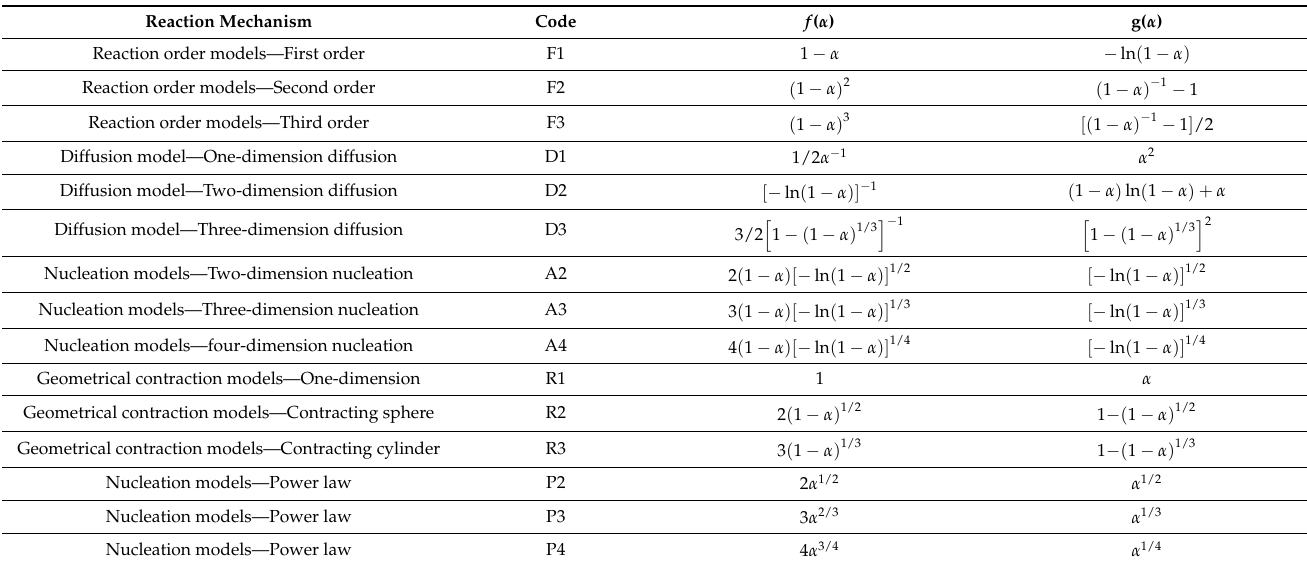
Table 4. Solid-state reaction mechanism (Mumbach et al. (2019) [10]).